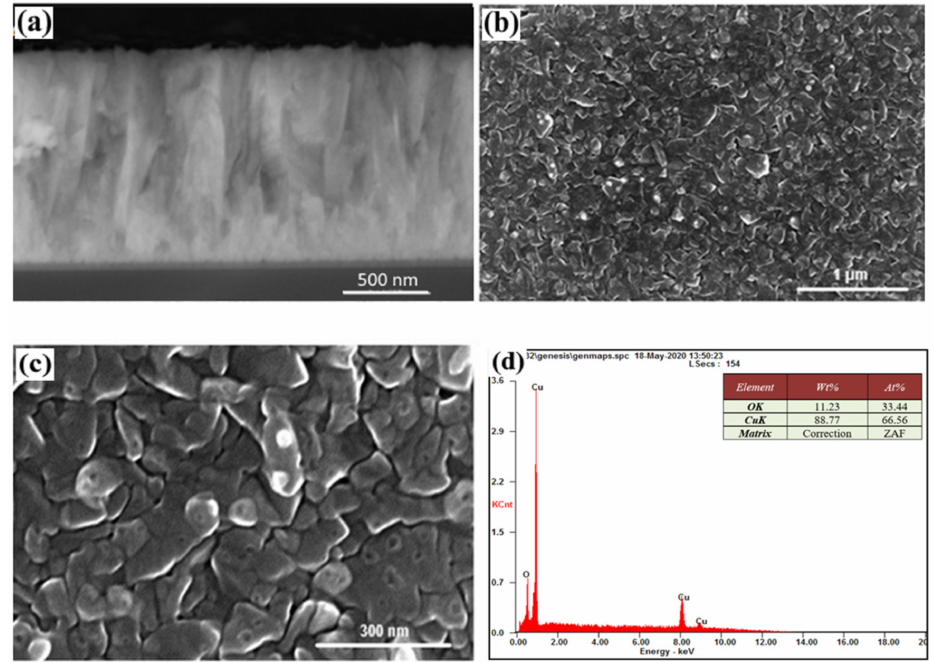
Figure 3. Cross-section ( a ), morphology ( b , c ) (for ( b ) reprinted with permission from Ref. [18]. Copyright 2021, Polish Academic of Sciences), and ( d ) chemical analysis of sample